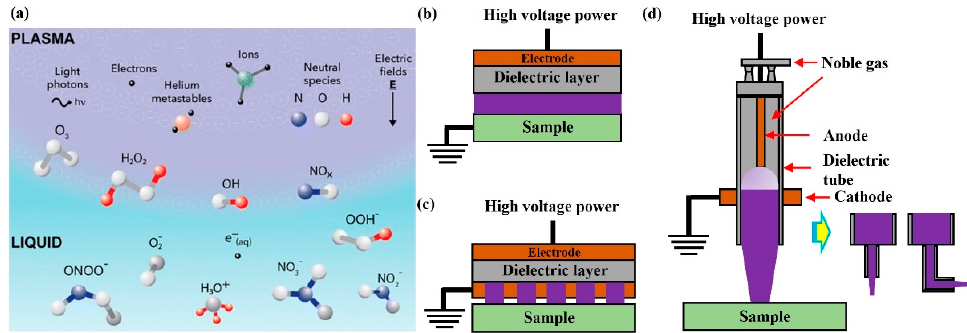
Figure 1. CAP sources used in plasma medicine. ( a ) A schematic illustration of typical component of CAP and reactive species formed in the CAP-treated liquid (reproduced with permission from Tumor Biology 37.6, 7021–7031 (2016). Copyright 2016 Springer Nature). ( b ) A volume DBD source. ( c ) A surface discharge source. ( d ) A CAP jet source. Volume and flow rate of jet can be modulated by the nozzle.